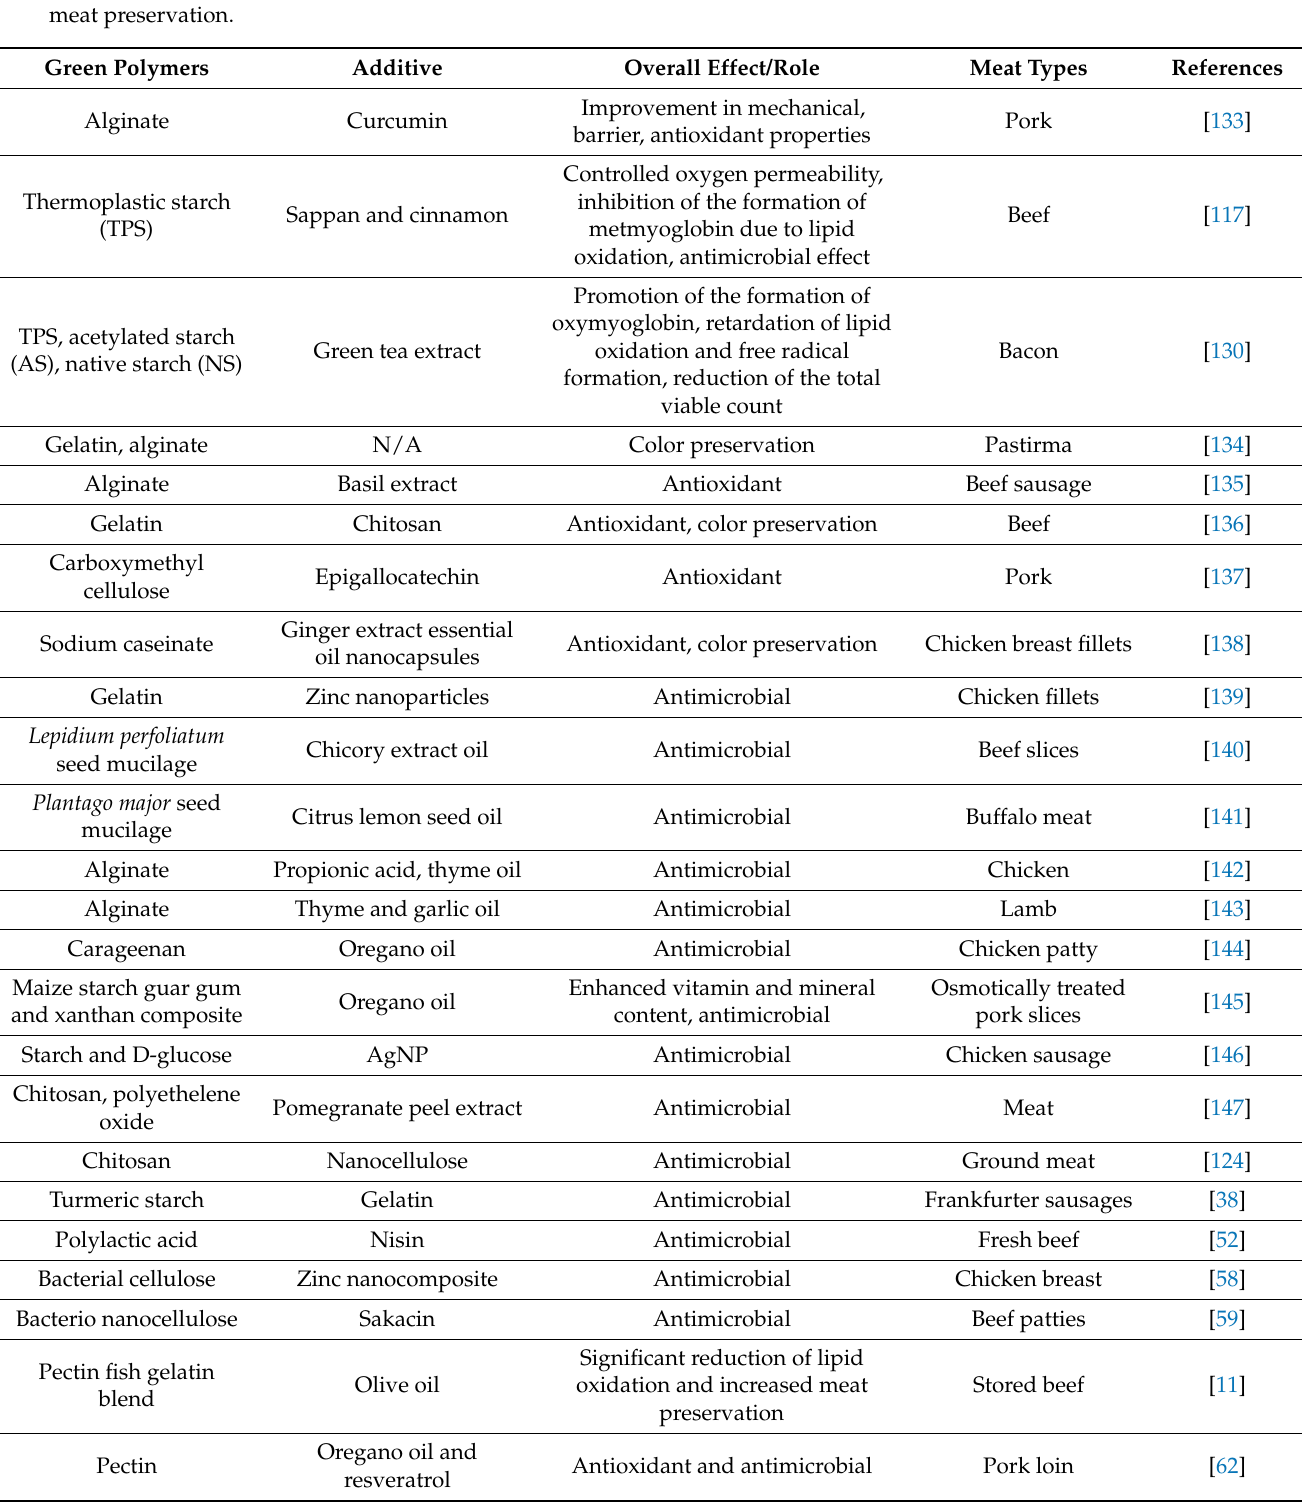
Table 2. A non-exhaustive list of examples using green polymers and additives and their overall role or effect in meat